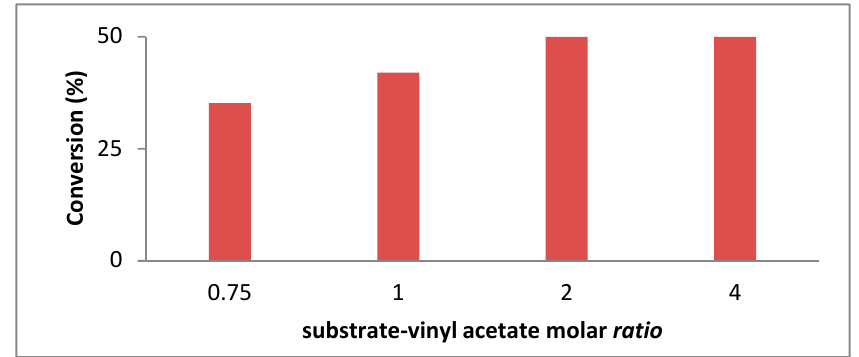
Figure 3. The influence of substrate: vinyl acetate molar ratio on the conversion of rac - 2a .